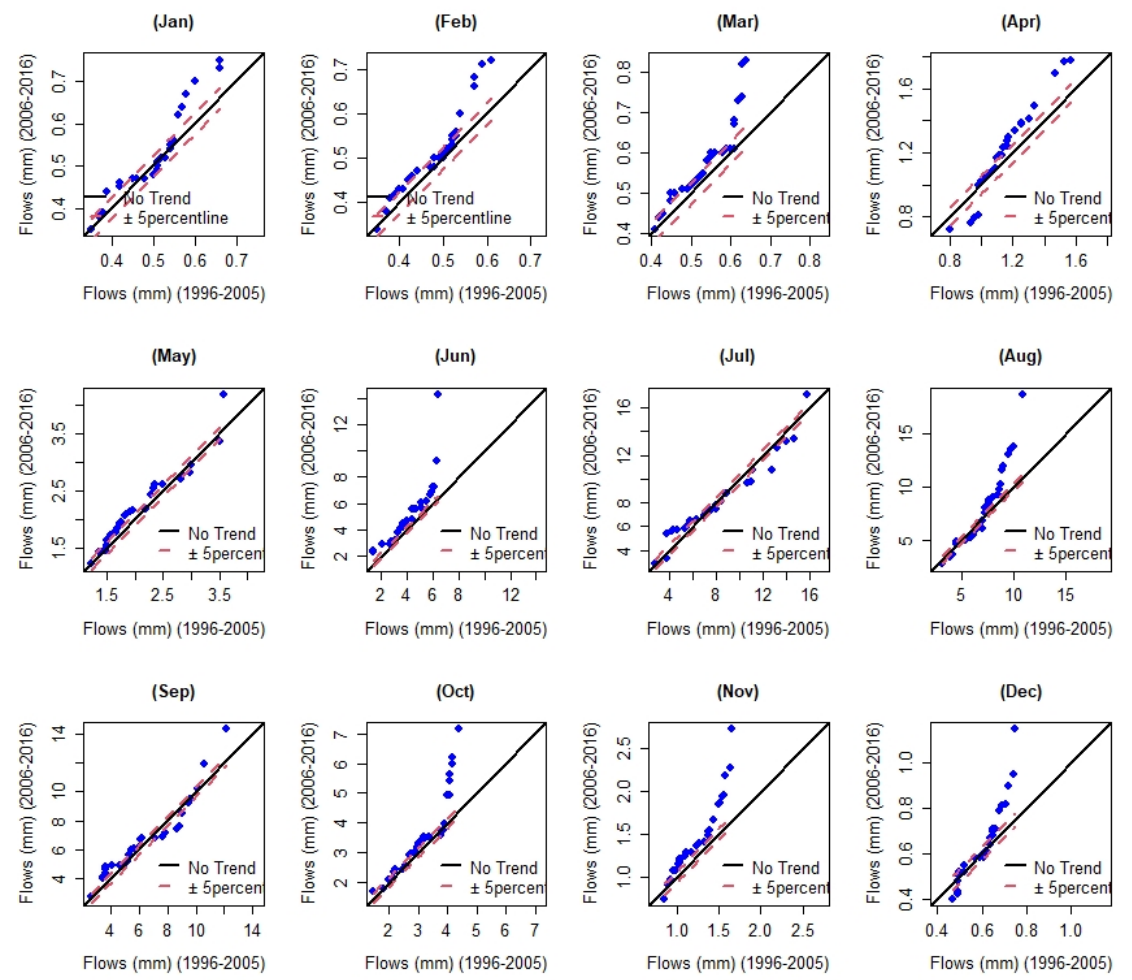
Figure 8. Mean monthly graphical representation of ITA results for streamflow at the Zhimenda hydrological station (1961 – 2016).